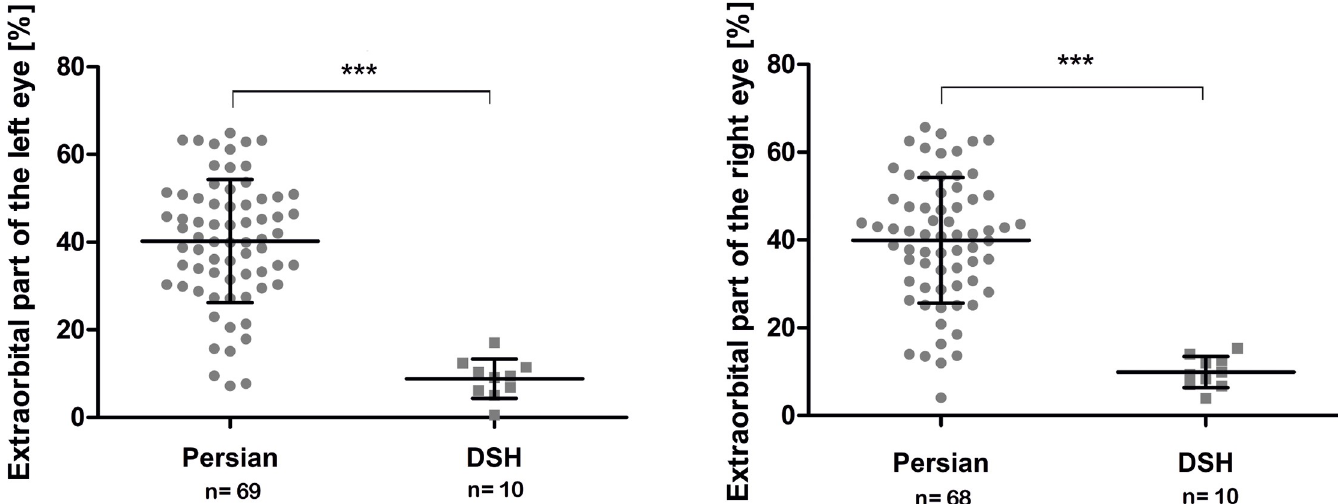
Fig 10. Comparison of the extra-orbital parts of the eye globes between Persian and DSH cats. Graphic representation of the extra-orbital parts of the right and left eye globes, comparing Persian and DSH cats. The values of the individual cats, the mean values, the standard deviations and the significance level are indicated. � = p < 0.01; �� = p < 0.001 ��� = p <